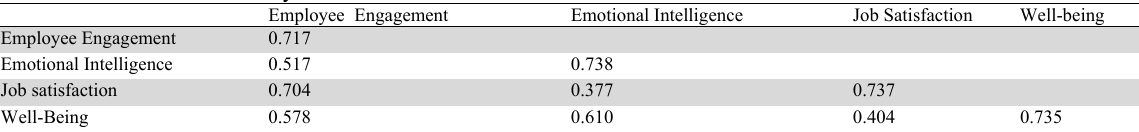
Results of Discriminant Validity Employee Engagement Emotional